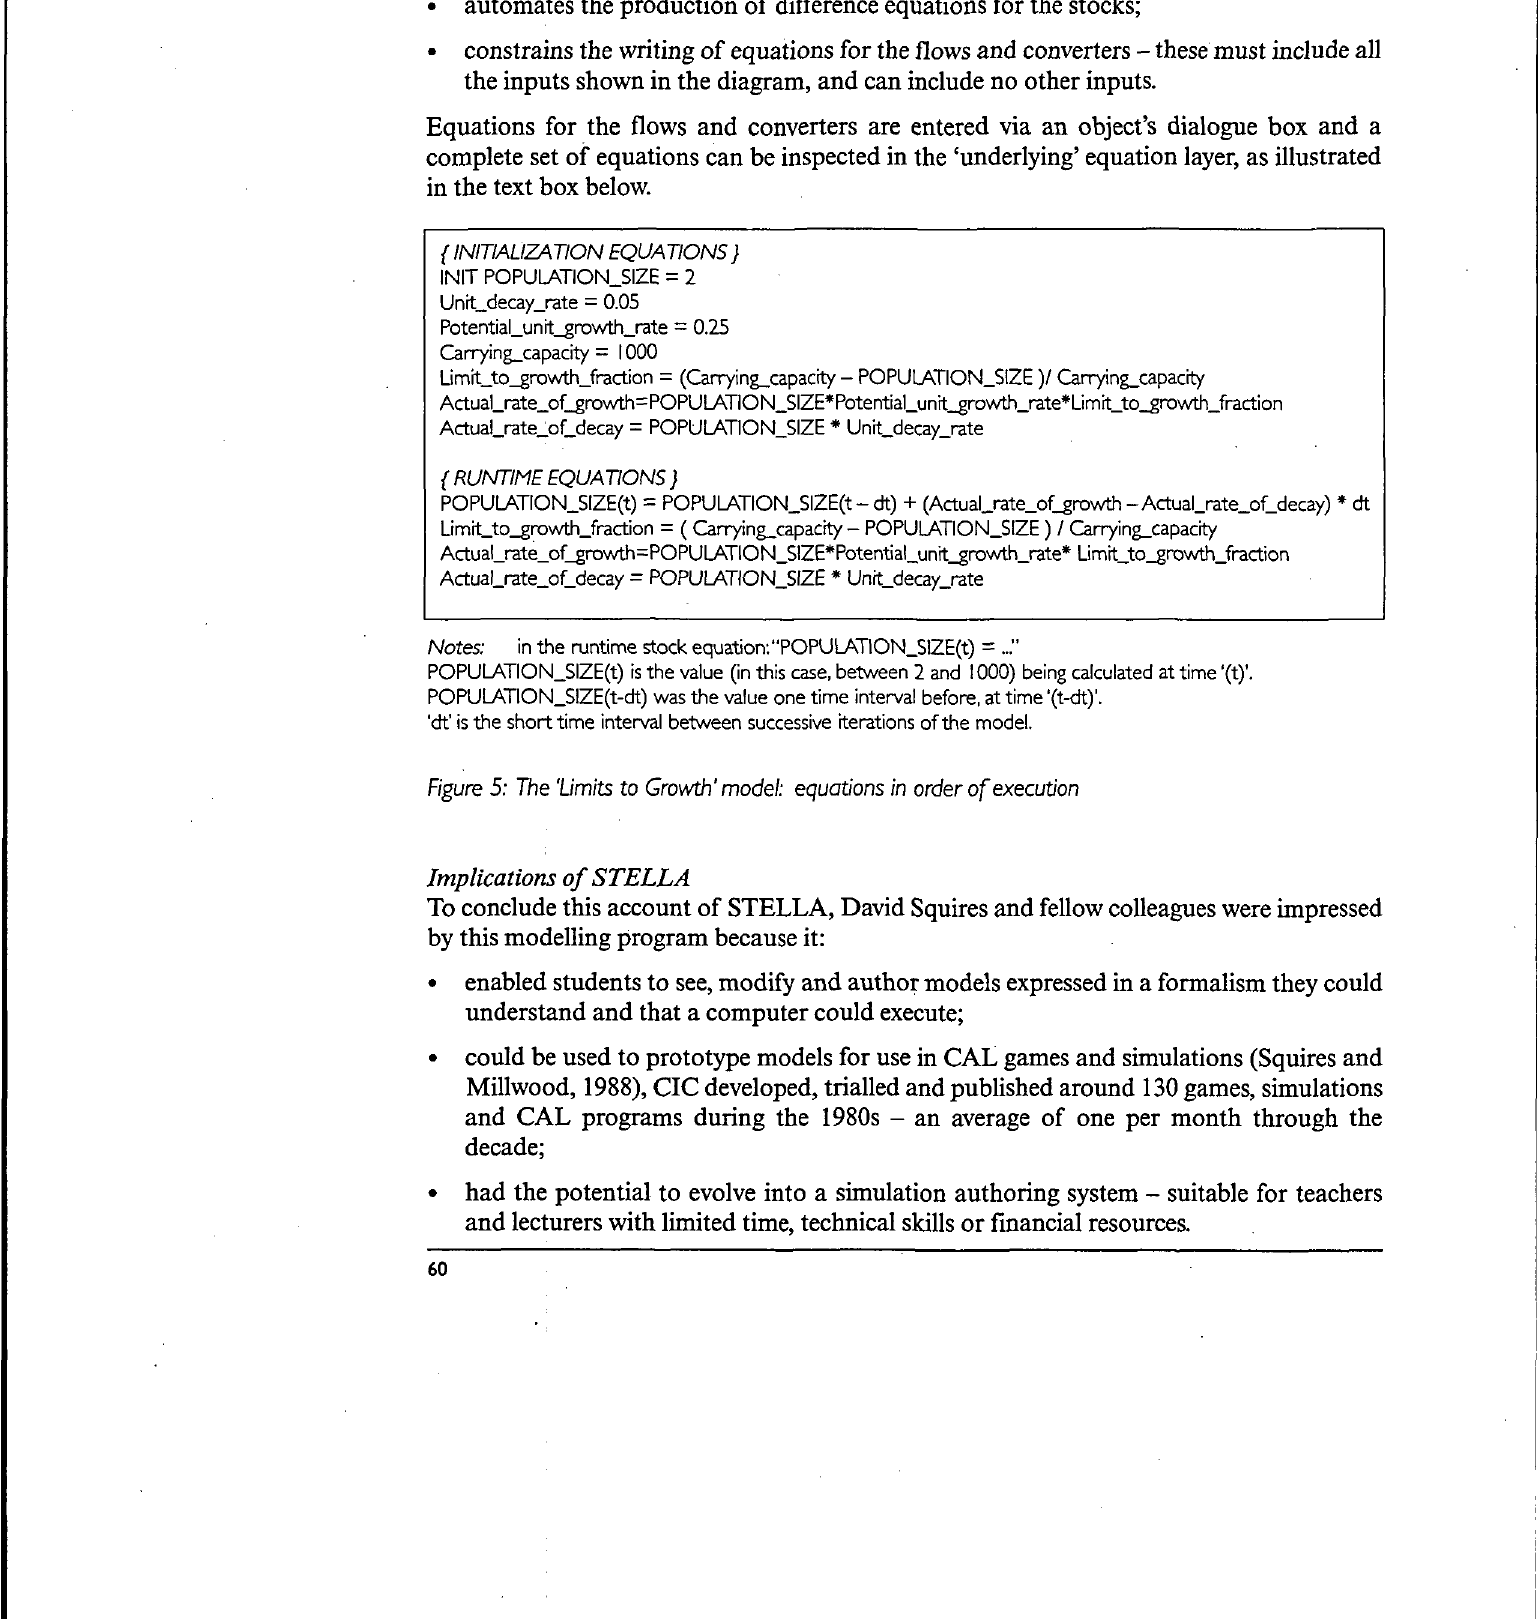
Implications of